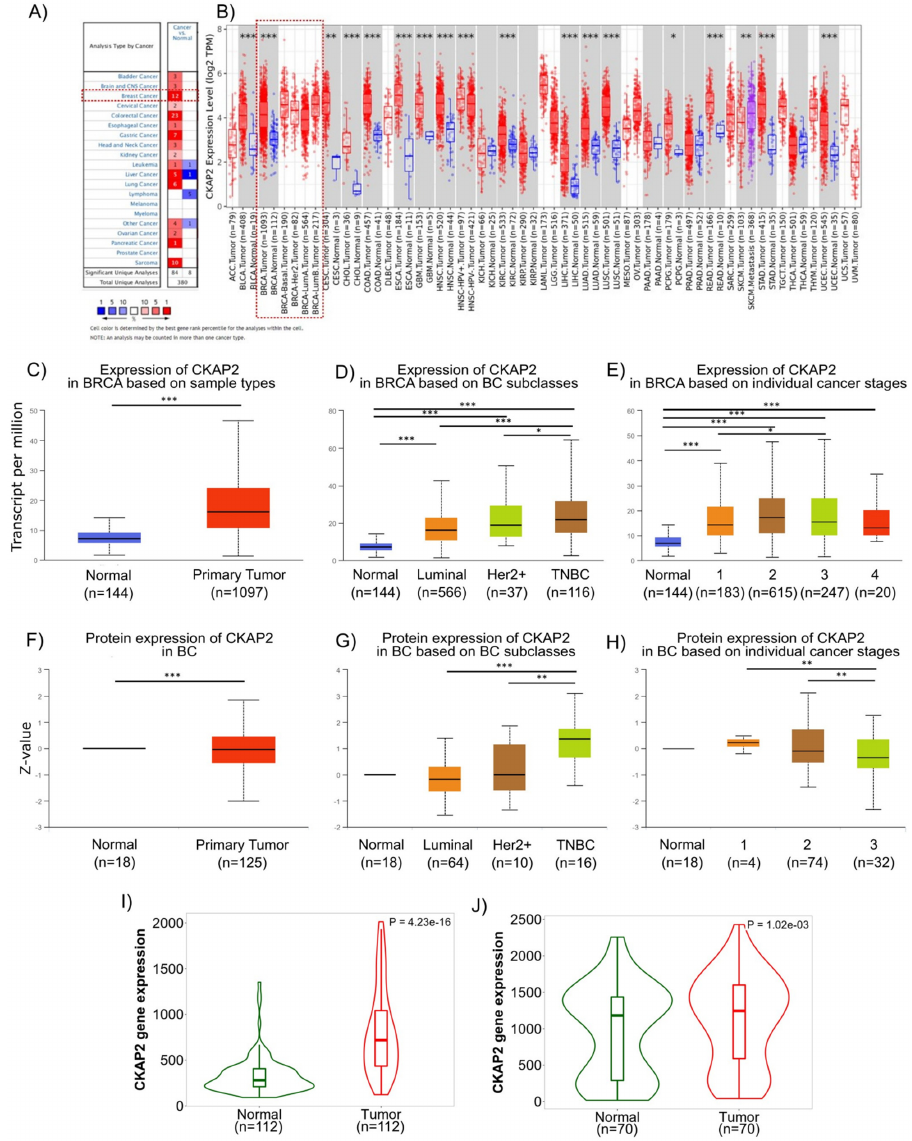
Figure 3. Human CKAP2 expression levels in different tumor types determined using Oncomine, Tumor Immune Estimation Resource (TIMER2.0), UALCAN (University of Alabama at Birmingham Cancer data analysis Portal), and TNMPLOT. ( A ) mRNA expression levels of CKAP2 in 20 cancer types from Oncomine. Numbers in red and blue cells represent dataset numbers in which levels of CKAP2 are statistically increased or decreased, respectively ( p < 0.05, a fold-change > 1.5, and gene rank top 10%). ( B ) CKAP2 expression in different cancers was analyzed by TIMER2.0. (* p < 0.05; ** p < 0.01; *** p < 0.001). ( C – E ) mRNA expression of CKAP2 in BC from UALCAN. Boxplots showing CKAP2 mRNA levels in healthy controls versus individuals with BC ( C ), BC subclasses ( D ), and based on BC stages ( E ) (* p < 0.05; *** p < 0.001). ( F – H ) CKAP2 protein expression analysis using data from Clinical Proteomic Tumor Analysis Consortium (CPTAC). Boxplots showing CKAP2 protein levels in healthy controls versus individuals with BC ( F ), BC subclasses ( G ), and based on BC stages ( H ). (** p < 0.01; *** p < 0.001). ( I , J ) CKAP2 expression from paired tumor and adjacent normal tissues using TNMPLOT. ( I ) Violin plot showing CKAP2 expression from RNA-seq data. ( J ) Violin plot showing CKAP2 expression from gene chip data. BC: breast cancer; HER2+: human epidermal growth factor receptor 2 positive; TNBC: triple negative breast cancer. Data with p < 0.05 were considered statistically